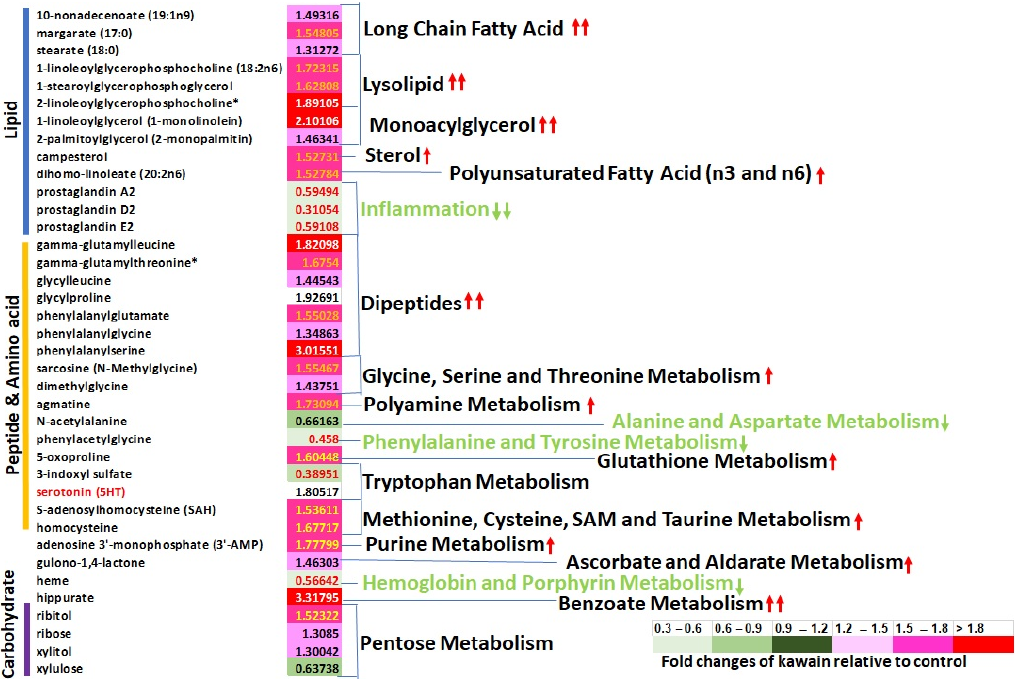
Figure 6. Kawain diet induces metabolic changes in bladder tumor tissues of the UPII Ha-ras mice. Differential levels of metabolites of lipid, peptide and amino acid, and carbohydrates of blad- der tumor tissues from seven pairs of control- vs. kawain-treated mice were detected by global bio-